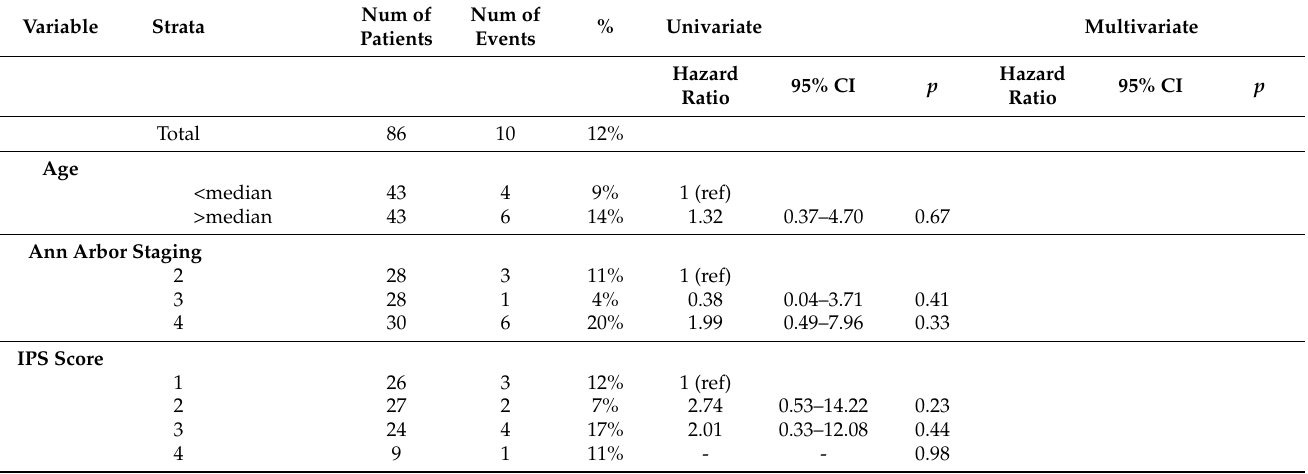
Table 2. Prediction of